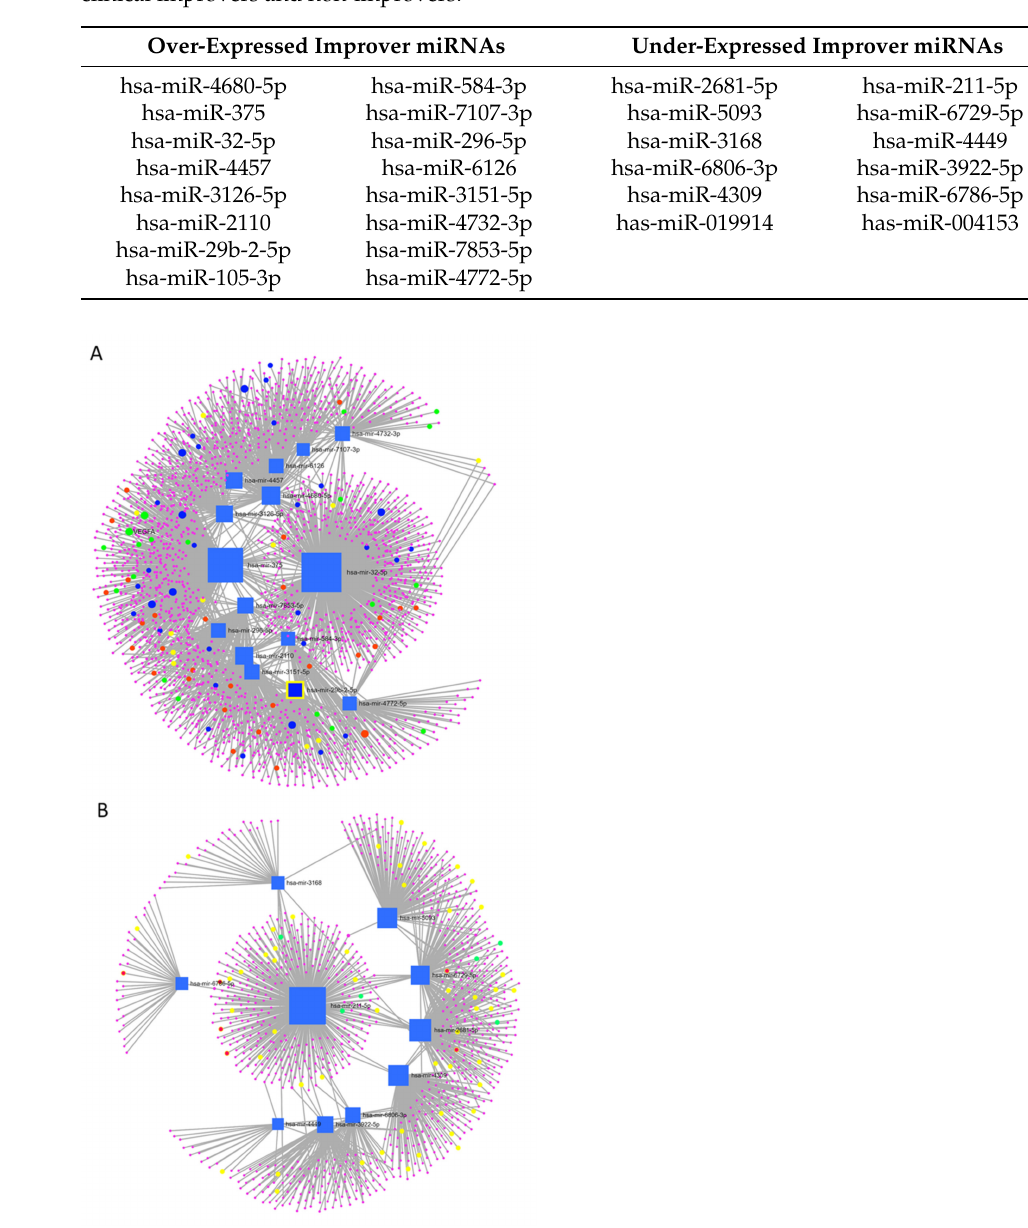
Figure 2. Network analysis showing the genes associated with differentially expressed microRNA ( n = 3). (A) Network analysis showing the genes associated with the overexpressed miRNA and enrichment analysis. (B) Network analysis showing the genes associated with the under-expressed microRNA: immune system and enrichment analysis (yellow dots), downregulation of TGF-beta re- ceptor signaling (green dots), and VEGFR2-mediated regulation (red dots) when comparing improver and non-improver